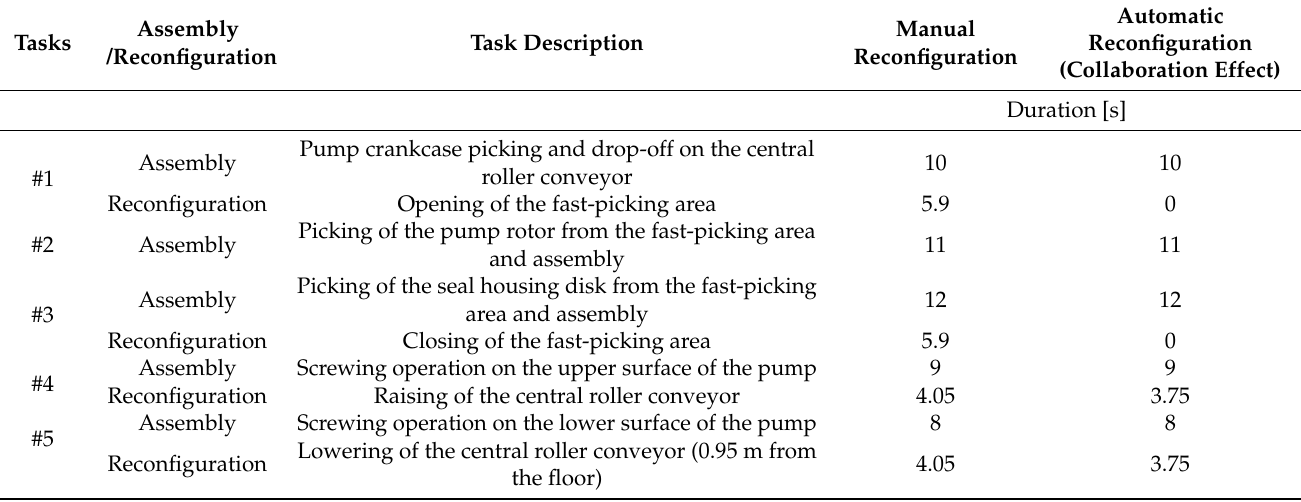
Table 4. Centrifugal electric pump assembly and reconfiguration tasks (Configuration #2.1 and